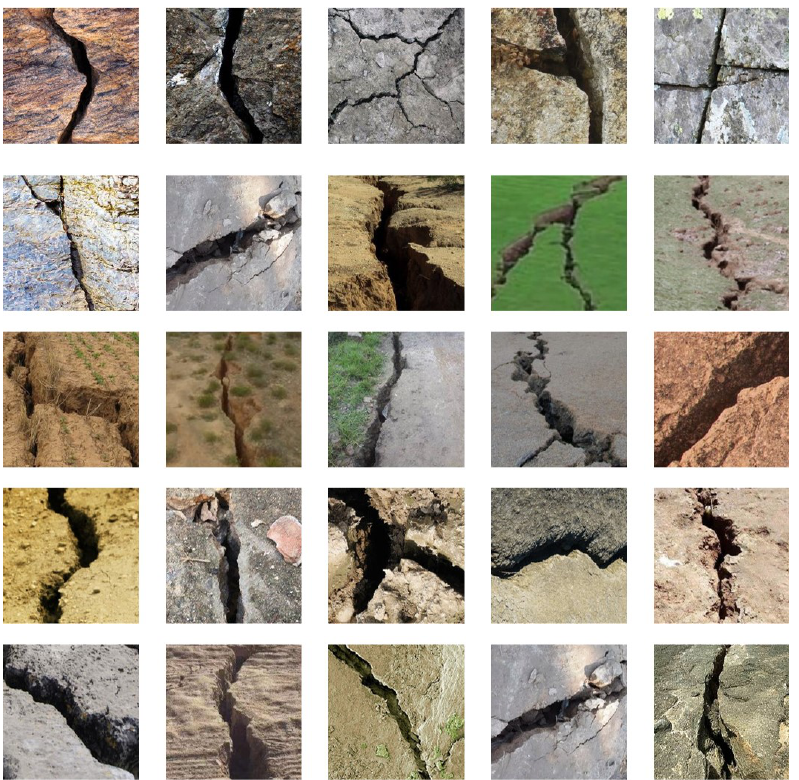
Figure 8. The dataset of surface cracks of soil and rock masses that contains the images of the cracks.